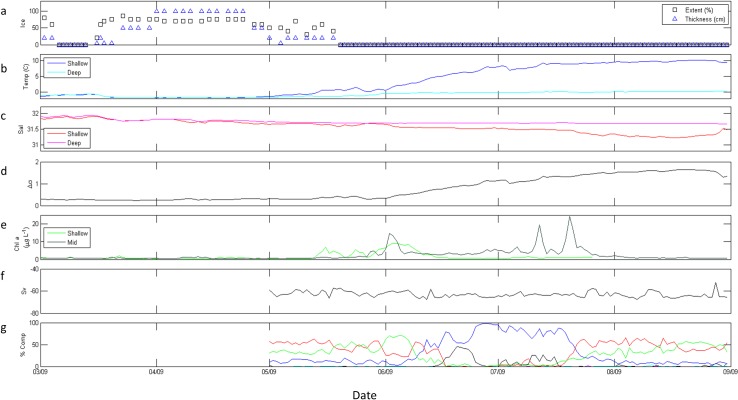
M2 data from March through August 2009.(a) ice extent (%, black boxes) and thickness (blue triangles); (b) shallow (dark blue) and deep (cyan) temperature (°C); (c) shallow (red) and deep (magenta) salinity; (d) stratification (Δσ); (e) shallow (light green) and mid-column (dark green) Chl a fluorescence (μg L-1); (f) total scattering volume (Sv); (g) percent composition of classes of scatterers, including SmCrust (black), MdCrust (blue), LgCrust (red), WkReson (green), StReson (cyan), and Unclass (magenta). Note that scattering data was unavailable March—April 2009.